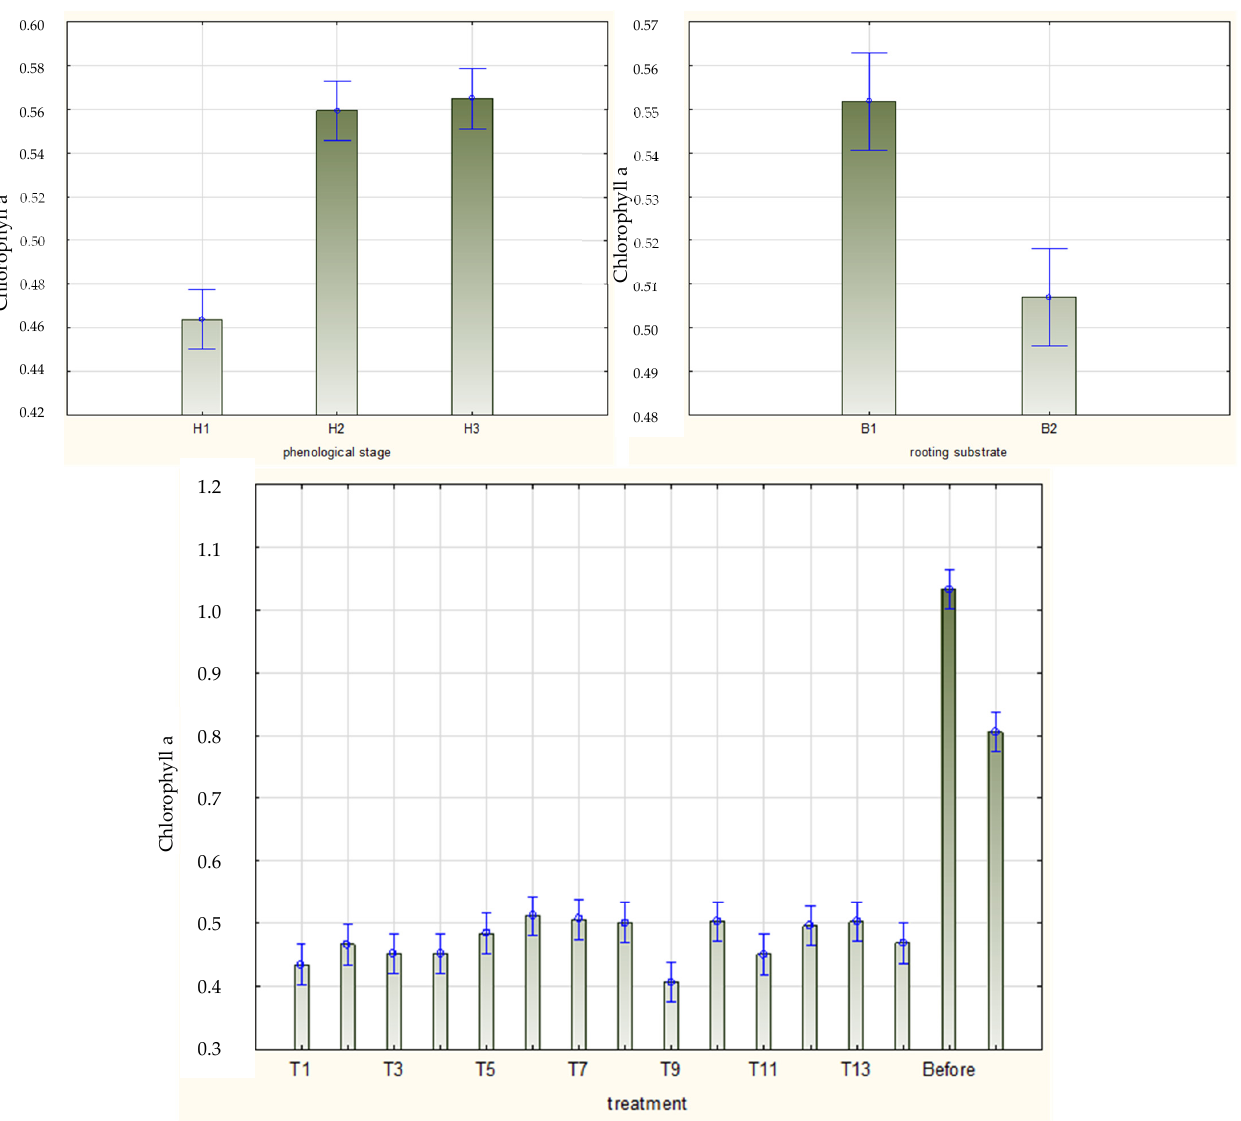
Figure 8. Content of chlorophyll a (mg · g − 1 FW) in leaves of Rosa ‘Hurdal’ cuttings prepared from three phenological stages (H1–H3) of shoots and rooted in two rooting substrates after treatment by rooting enhancers. B1—peat–perlite; B2—peat–sand; H1—flower buds closed (BBCH 54,504; flower buds still closed); H2—flowers opened (69,605; full flowering, at least 50% of flowers open); H3—immediately after petal shedding (69,629; end of flowering of second order stem: all petals fallen); and treated: T1—the control cuttings; T2—0.4% IBA (Ukorzeniacz A aqua ); T3—0.2% NAA (Ukorzeniacz B aqua ); T4, T5, T6, T7, T8, T9—Algae Extract: watering with 0.4% or 0.6% Bio Rhizotonic (10 mL) 1, 2, or 3 times (after planting and 10 and 20 days later); T10, T11, T12—Organic Preparation— watering with 0.1%, 0.2%, or 0.4% Root Juice™ (10 mL) after planting; T13, T14—Plant Extract— watering with 0.012% or 0.02% Bio Roots (10 mL) after planting. The degree of rooting on a 5-point scale: 1—only a callus, without formed roots; 2—at least one short root; 3—a few longer roots; 4—roots visibly developed, differentiated by the length; 5—strong roots starting to form a root ball, well developed. Vertical bars denote 95% confidence intervals for the mean of counts (one-way ANOVA).